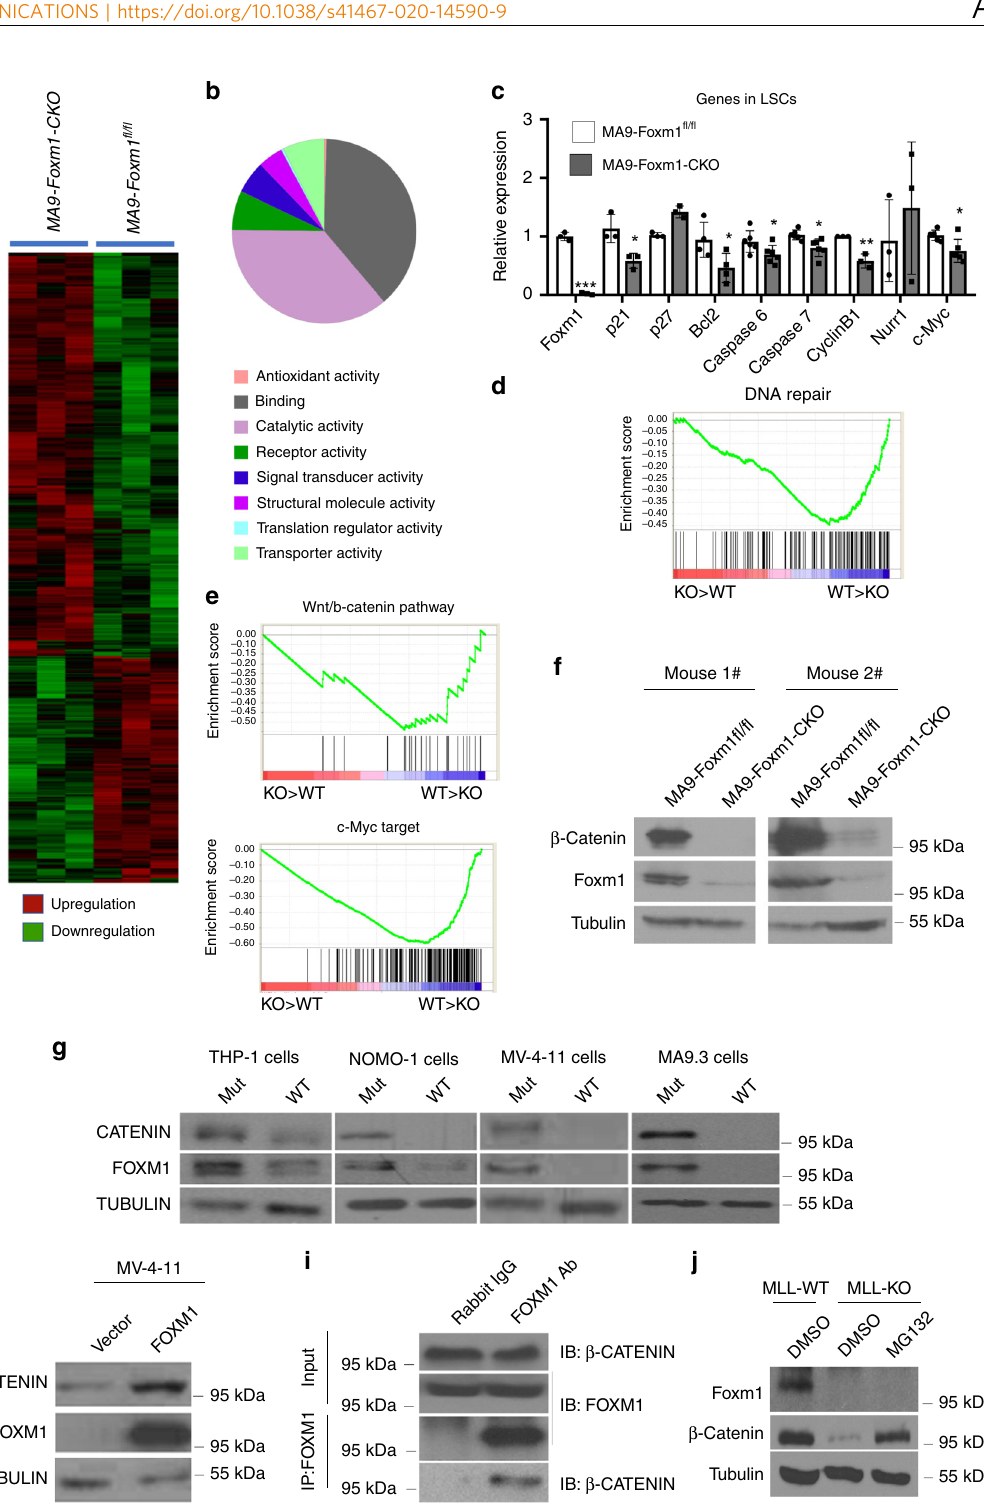
proteasome inhibitor, restored the β -CATENIN expression in MA9-Foxm1-CKO BM cells from the recipient mice (Fig. 6j). Interestingly, the endogenous polyubiquitination of β -catenin was signi fi cantly increased in MA9-Foxm1-CKO BM cells as compared to MA9-Foxm1 fl / fl BM cells (Supplementary Fig. 7d). In addition, we found that overexpression of Foxm1 in mice wildtype BM cells did not increase the expression of β -catenin (Supplementary Fig. 7e, f). As determined by fl ow cytometric analysis (Supple- mentary Fig. 7g, h), Foxm1 loss did not destabilize β -catenin in normal HSC in vivo. These results showed that in leukemia